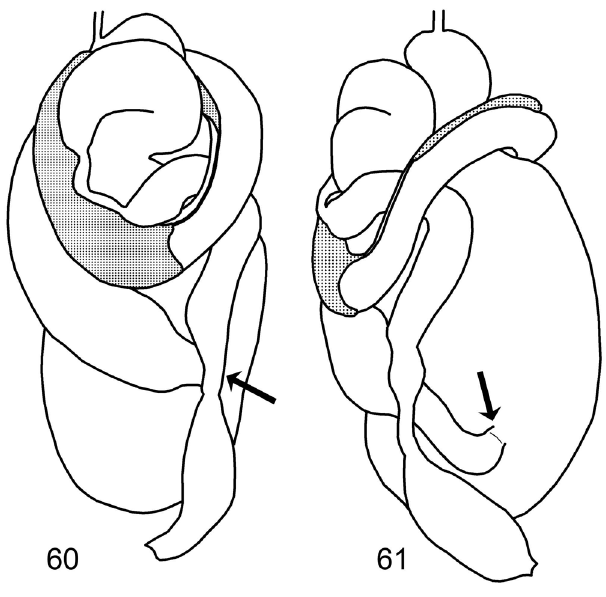
Figs 60–61. Worker gut of Amitermes amifer 60- dorsal view; 61- right view (arrows: insertion of enteric valve on the right side of P3).